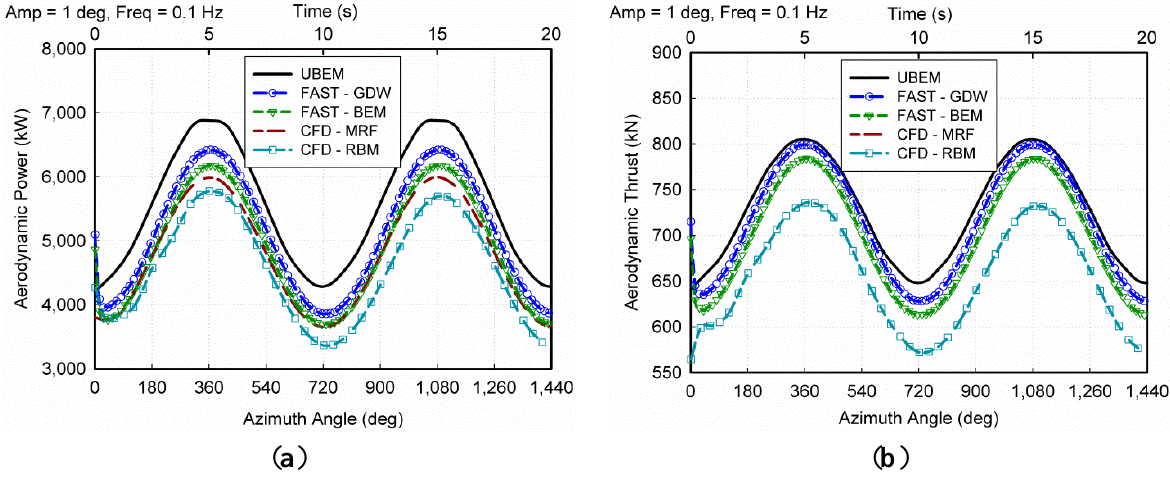
Figure 7. Unsteady aerodynamic comparison using the UBEM, CFD and FAST (NREL) methods for a platform pitching motion with an amplitude of 1° and a frequency of 0.1 Hz. ( a ) Aerodynamic Power; and ( b ) Aerodynamic Thrust.